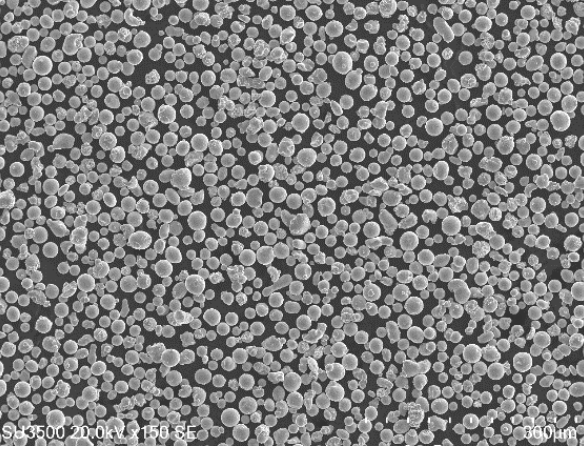
Figure 1. SEM micrograph of the 316LSS powder morphology.